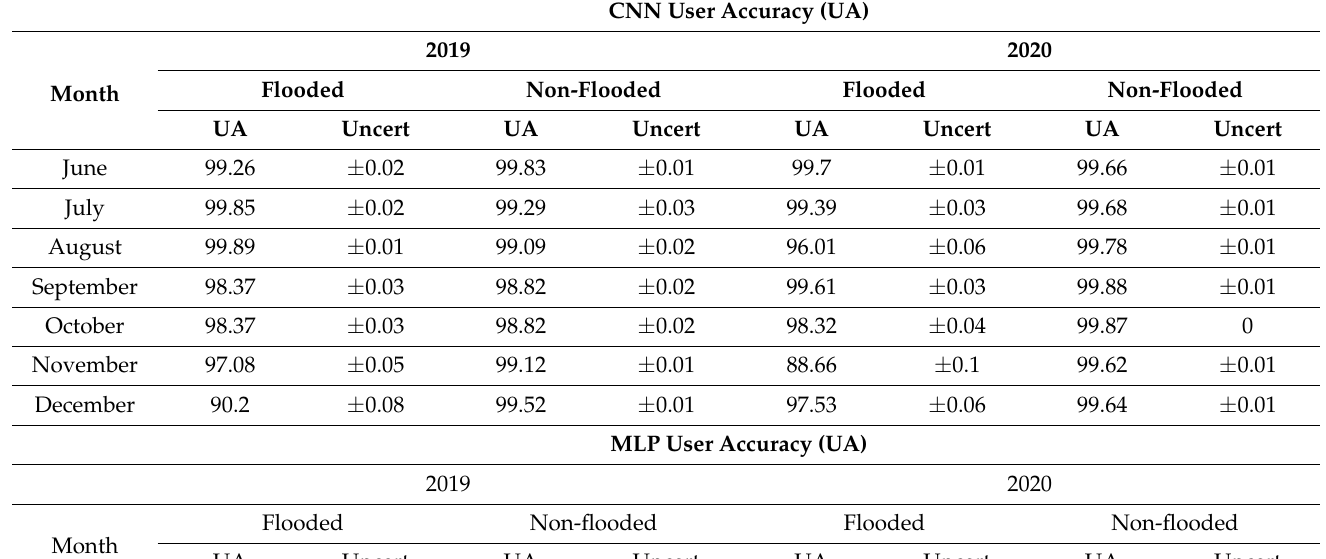
Table 7. UA and uncertainty of CNN, MLP and RF classifiers by month for the wet season. CNN User Accuracy